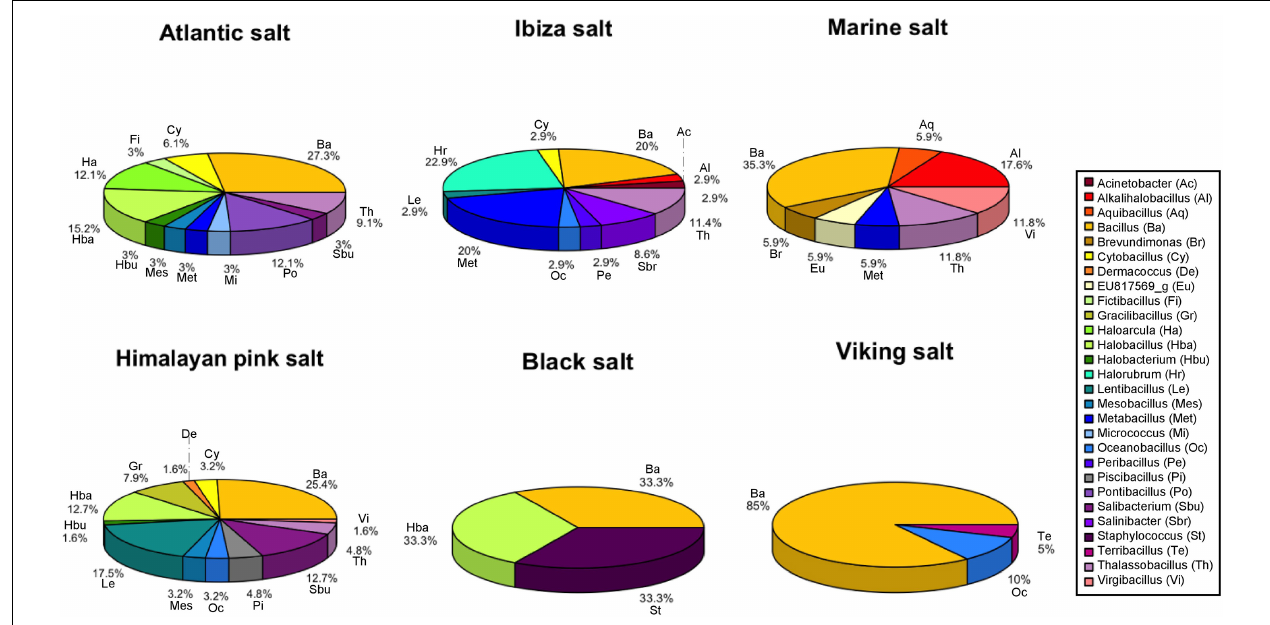
FIGURE 2 | Microbial profiles of six table salt samples based on the identification of culturable isolates. The percentage indicates that the value was calculated based on the total number of isolates in each table salt. The abbreviation is correlated to the genus name: Ac, Acinetobacter ; Al, Alkalihalobacillus ; Aq, Aquibacillus ; Ba, Bacillus ; Br, Brevundimonas ; Cy, Cytobacillus ; De, Dermacoccus ; Eu, EU817569_g; Fi, Fictibacillus ; Gr, Gracilibacillus ; Ha, Haloarcula ; Hba, Halobacillus ; Hbu, Halobacterium ; Hr, Halorubrum ; Le, Lentibacillus ; Mes, Mesobacillus ; Met, Metabacillus ; Mi, Micrococcus ; Oc, Oceanobacillus ; Pe, Peribacillus ; Pi, Piscibacillus ; Po, Pontibacillus ; Sbu, Salibacterium ; Sbr, Salinibacter ; St, Staphylococcus ; Te, Terribacillus ; Th, Thalassobacillus ; Vi, Virgibacillus